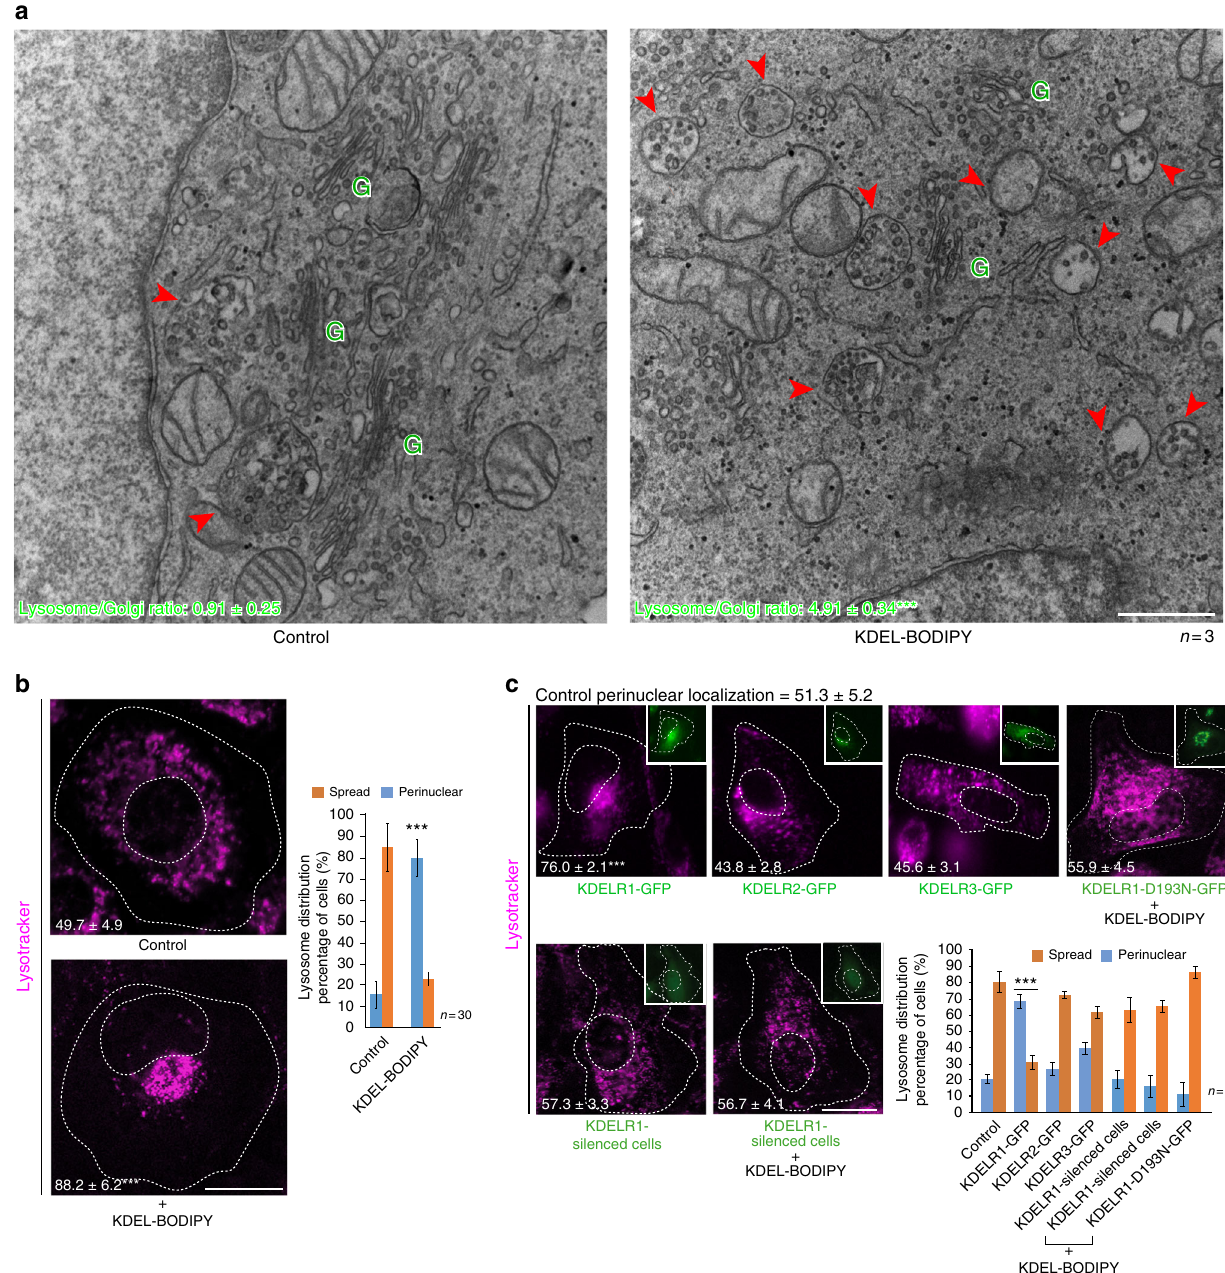
Fig. 2 Lysosome repositioning is dependent on the KDELR1 isoform. a To activate KDELR, HeLa cells were incubated for 30 min with 1 µ M KDEL-BODIPY peptide. Cells were fi xed with glutaraldehyde and processed for electron microscopy analysis. The ratio of lysosomes (red arrowheads) with respect to Golgi stacks (green Gs) was calculated as described in Methods, and the values are indicated at the bottom of each image (three independent experiments). Scale bar, 500 nm. b HeLa cells treated as in a were stained with DeepRed-Lysotracker, and its radial integrated fl uorescence intensity was used to quantify the distribution of lysosomes as described in Methods. The graph shows the percentage of cells depicting cytoplasmically spread or perinuclear lysosome distribution. The perinuclear distribution of lysosomes was quanti fi ed, and the values are indicated at the bottom of each image ( n = 30 cells). Scale bar, 10 µ m. c HeLa cells were transfected (insets) to overexpress either of the indicated green fl uorescent protein (GFP)-tagged KDELR isoform or GFP-tagged signalling-defective KDELR1-D193N in the presence of KDEL-BODIPY, or with a short hairpin RNA (shRNA) to silence KDELR1 expression in the absence or presence of KDEL-BODIPY. Lysosomes were stained and their distribution quanti fi ed as indicated in b . The graph shows the percentage of cells depicting cytoplasmically spread or perinuclear lysosome distribution. The perinuclear distribution of lysosomes was quanti fi ed, and the values are indicated at the bottom of each image ( n = 30 cells). Scale bar, 10 µ m. Data are means ± SEM. *** p < 0.001 (Student ’ s t tests). All t tests were conducted comparing to control